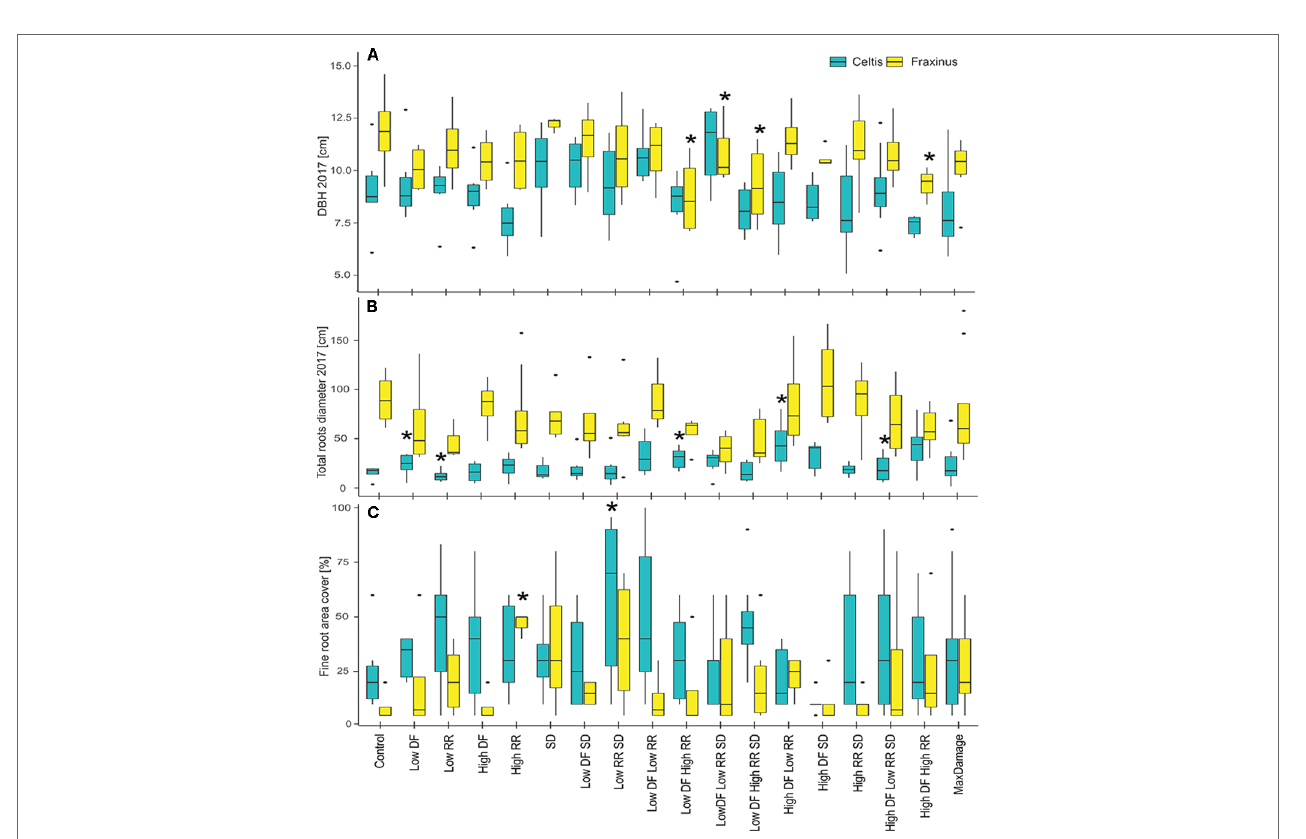
FIGURE 7 | (A) DBH measurements in 2017, (B) total larger roots area, measured at 20 cm from the stem center, and (C) percent area covered by fine roots for the two tree species and all damage treatments, alone and in combination. All damage treatments are compared to the control group for the respective species. Significant difference performance is indicated by an asterisk (ANOVA P > 0.05). The difference between the two species growth is also significant in all three